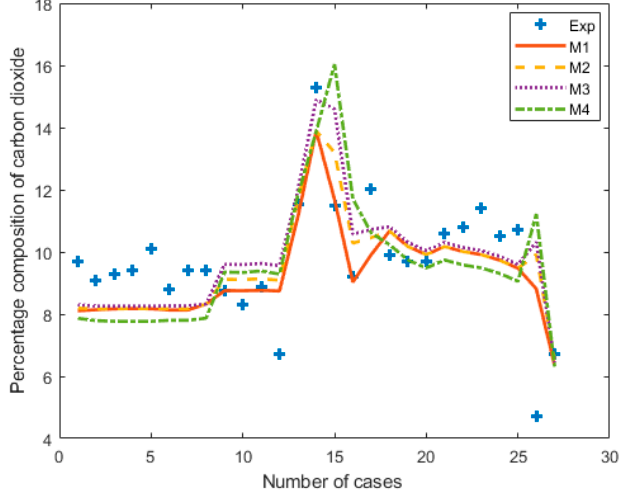
Figure 5. Comparison of the carbon dioxide composition with experiments and models.